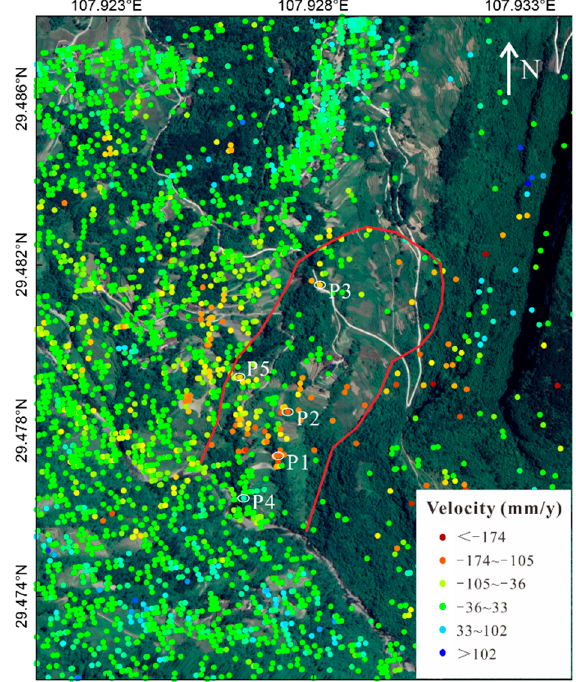
Figure 12. Mean velocities registered by Sentinel-1 satellites.